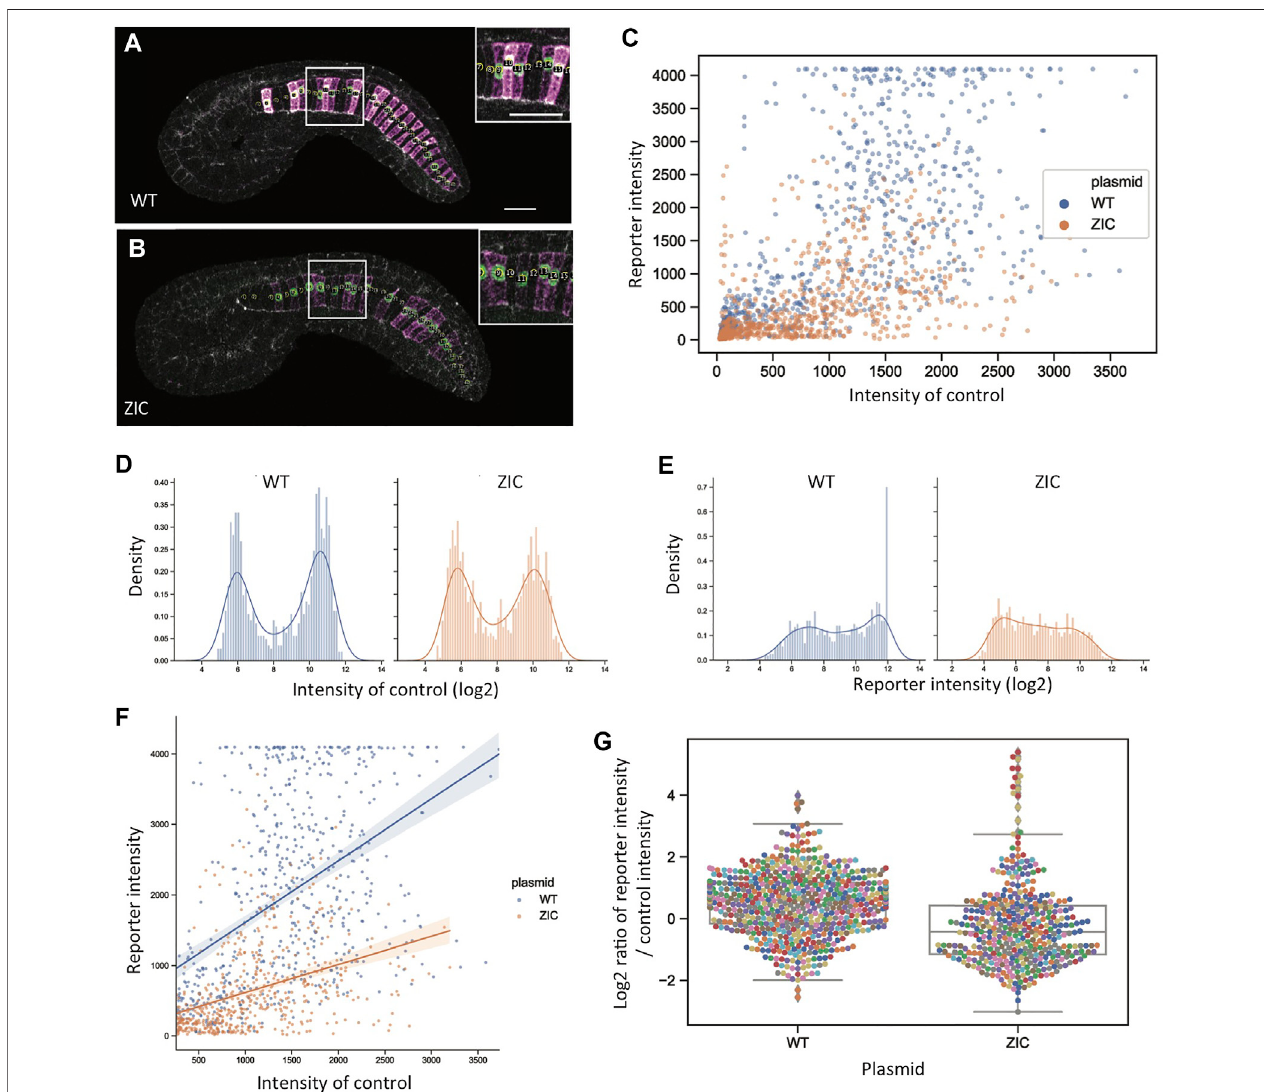
FIGURE 7 | Single-cell reporter quantitation. (A, B) Computationally fl attened mid-notochord slices for representative wildtype (A) and ZIC (B) embryos. Insets showzoomedinviewswithdisk-shapedROIsmarked.Magenta:YFPreporterexpression.Green:Bra > H2B:Hinternalcontrolexpression.Scalebar,20 µm. (C) Scatter plot for intensity of reporter ( y -axis) and internal control ( x -axis). Blue: wildtype. Orange: ZIC. (D,E) Histogram distributions for the log2-transformed intensity of internal control (D) andreporter (E) expression.Blue:wildtype.Orange:ZIC. (F) Scatterplotofreporterandinternalcontrolintensityforcellswithdetectableinternalcontrol expression(internalcontrolexpression > 256).Linearregressionlinesshowthatthereisstillarelationshipbetweenreporterexpressionandinternalcontrolexpressionfor the ZIC construct, but with a decreased slope compared to the wildtype construct. Blue: wildtype. Orange: ZIC. (G) Distributions of the log2-transformed ratio of intensities between reporter expression and internal control expression for the control expressing cells (internal control expression > 256).